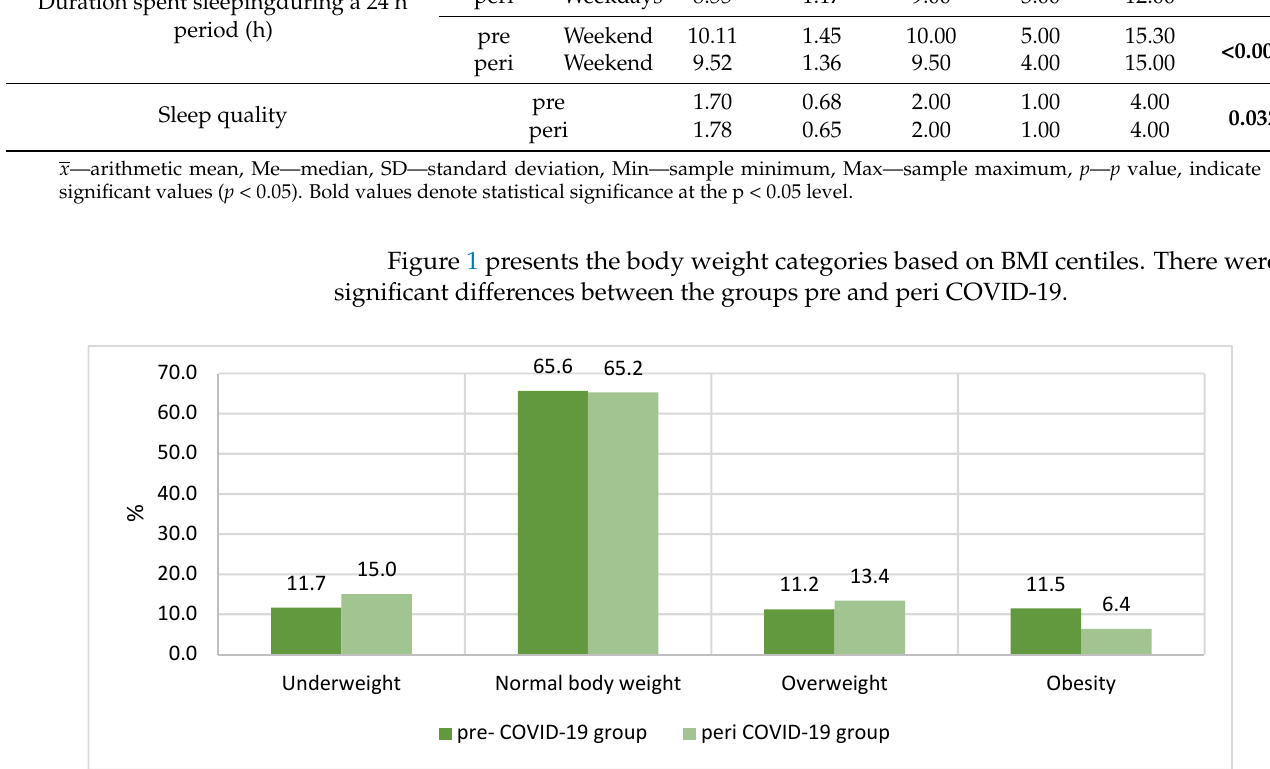
Figure 1. Body weight categories based on BMI centiles in the groups pre‐ and peri COVID‐19 ( p = 0.065). Characteristics of media usage in the groups pre‐ and peri COVID‐19 are presented